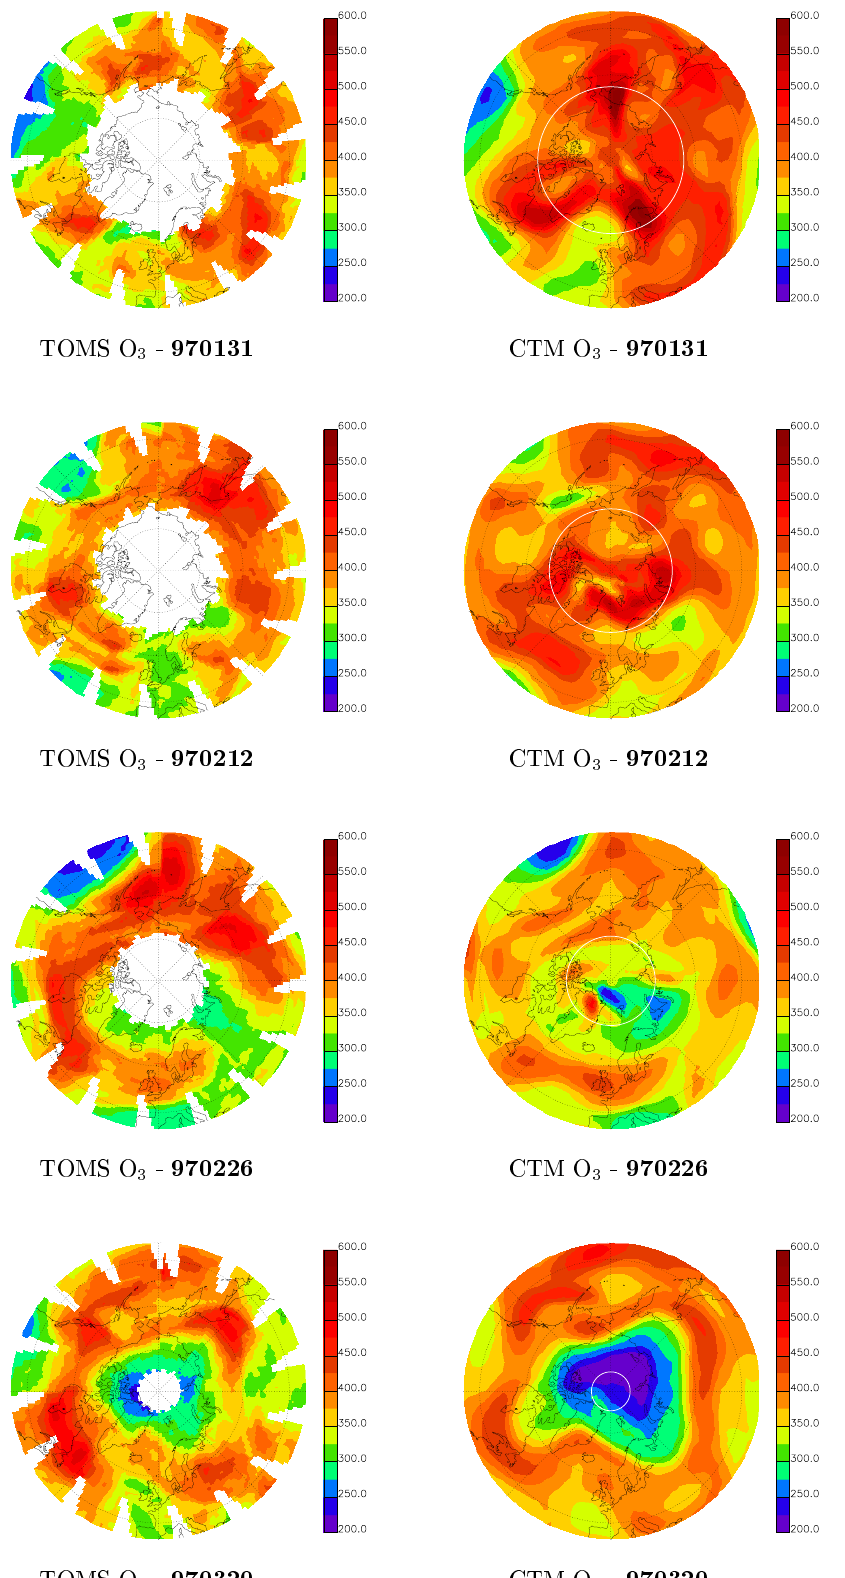
Fig. 5. False color maps of total ozone distribution (Dobson Units) measured by TOMS (left column) and modelled with STRATAQ CTM (right column), on 31 January, 12 February, 26 Febru- ary, 20 March 1997. CTM data are for 12:00UTC while TOMS data are asyn- optic fields obtained near local noon. Superimposed in white are the latitude circles that approximately correspond to the polar zone where the TOMS data are missing due to an absence of solar